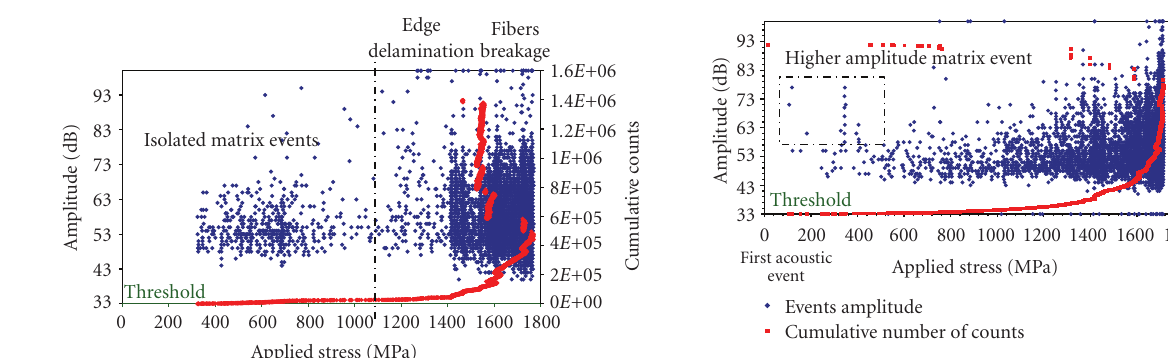
Figure 6: Typical acoustic behavior under tensile load of a sample without integrated inclusion.